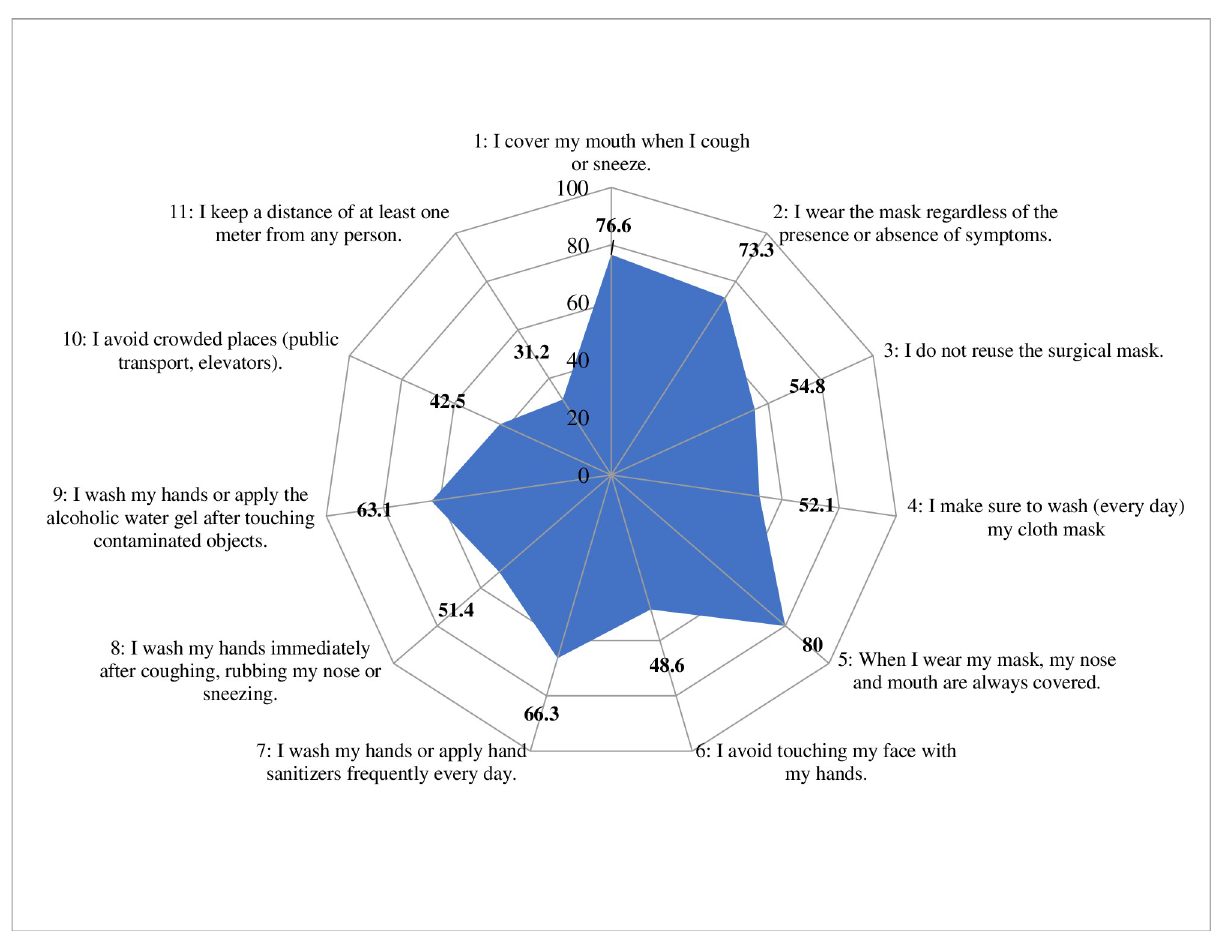
Fig 1. Frequency of “Always” response to the precautionary measures’ items.